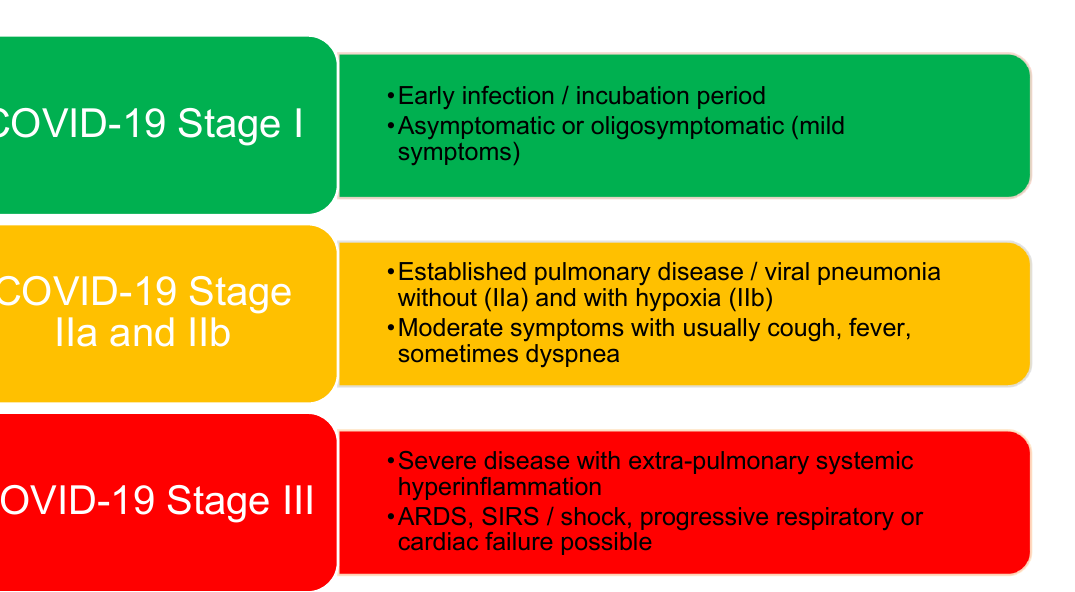
Figure 1. COVID-19 stages as suggested by Siddiqi and Mehra with brief descriptions of their